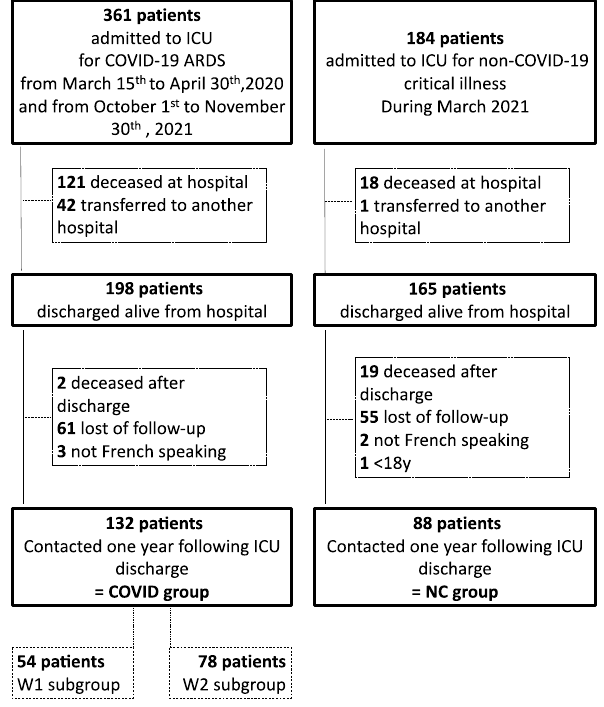
Figure 1. Flow chart (ARDS: acute respiratory distress syndrome; ICU: intensive care unit).